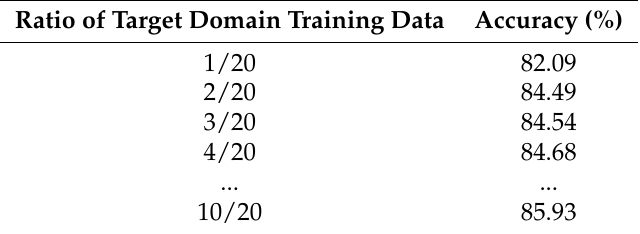
Table 4. Effect of the labeled target domain data ratio for training T course (average accuracy of all cross-domain classification subtasks